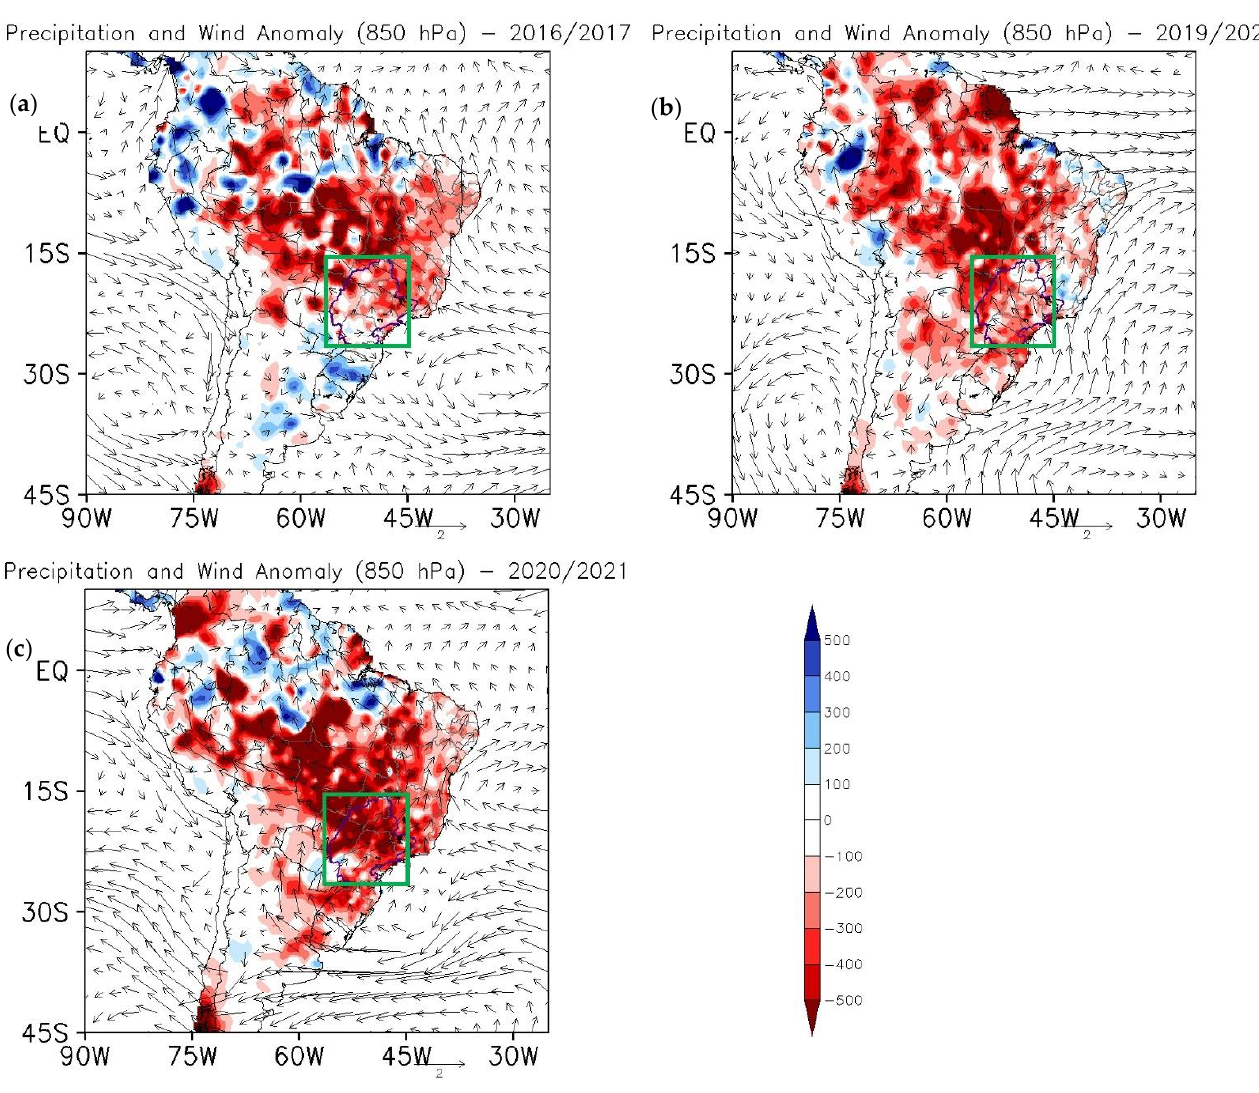
Figure 6. Anomalies of precipitation (mm) and wind at 850 hPa (reference vector is 2 m s -1 ), considering the subtraction of the rainy season (Oct – Mar average) of 2016/2017 ( a ), 2019/2020 ( b ), and 2020/2021 ( c ) from the normal conditions registered during Oct – Mar (1979-2021); ( a ) monthly (mm) and ( b ) annual climatology for the PHR, considering the period from 1979 to 2021. The bold green box on the map indicates the PHR. Data source: CPC.